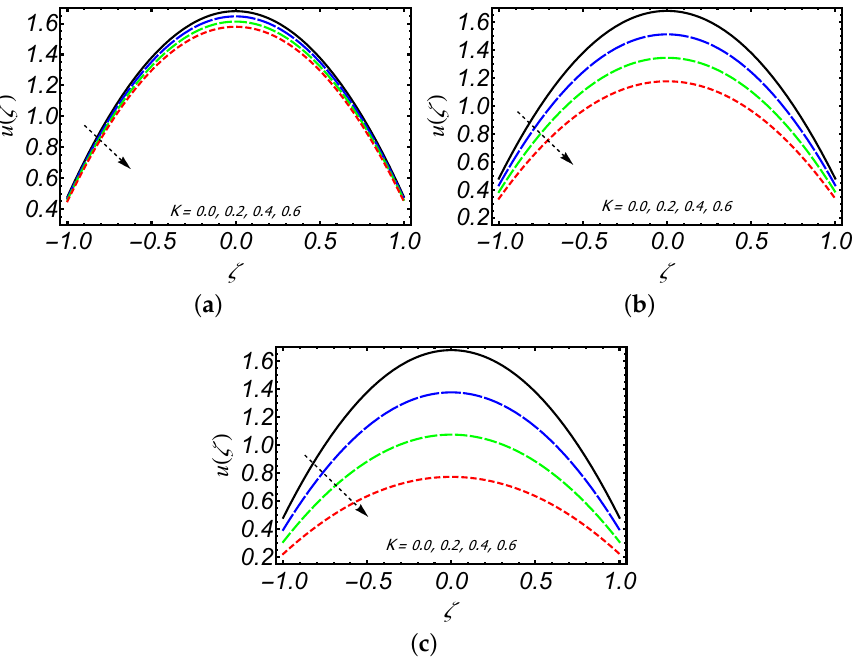
Figure 3. Behavior of u ( ζ ) with K at ( a ) x = 0.1, ( b ) x = 0.5, ( c ) x = 0.9, when φ = 0.2, δ =